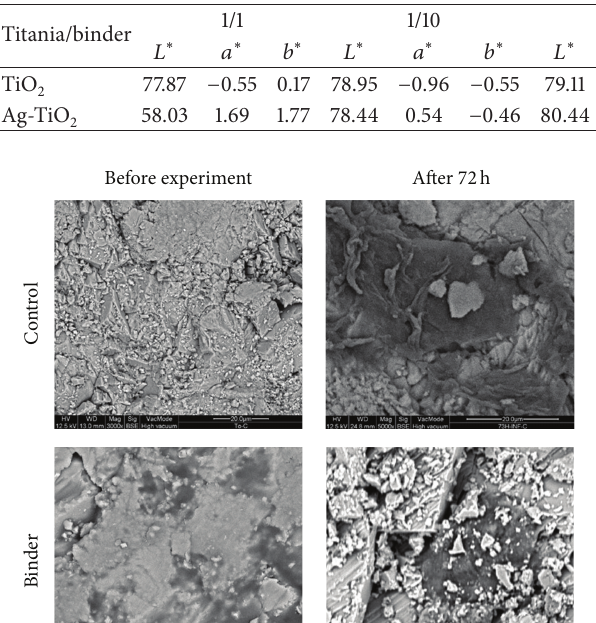
Table 2: Colorimetric measurement of treated and untreated surfaces.